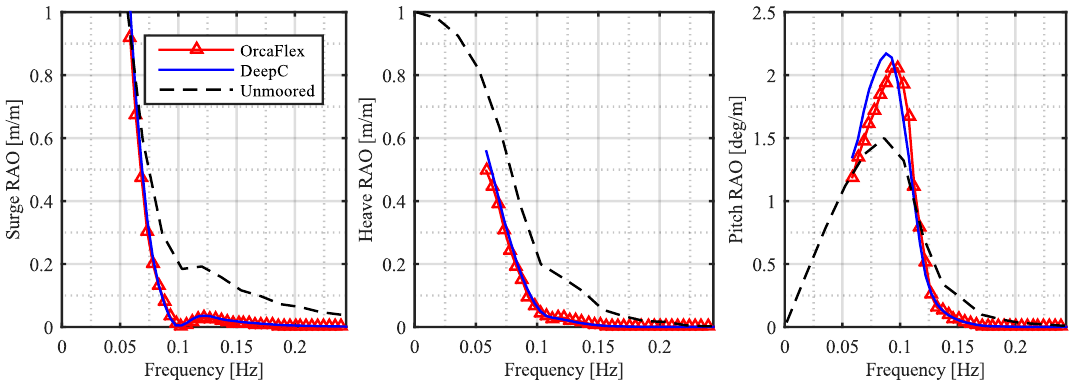
Figure 5. Motion RAOs for the surge, heave and pitch DOF of the moored WEC obtained from both the OrcaFlex and DeepC